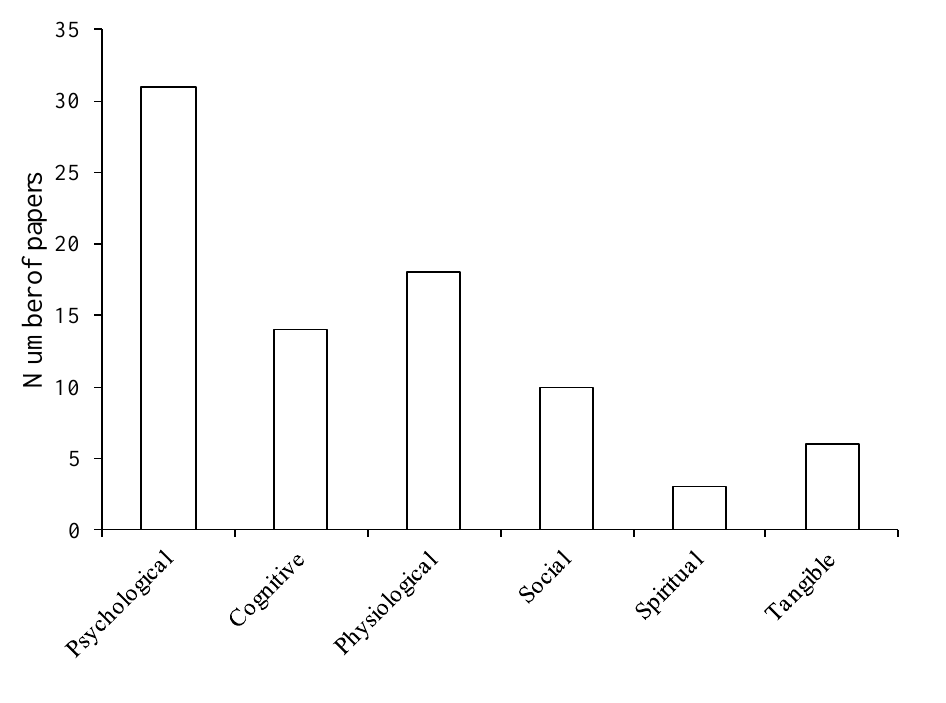
Figure 3. Number of studies that have investigated each type of benefit (n = 82). Where a study investigated more than one benefit, each is separately